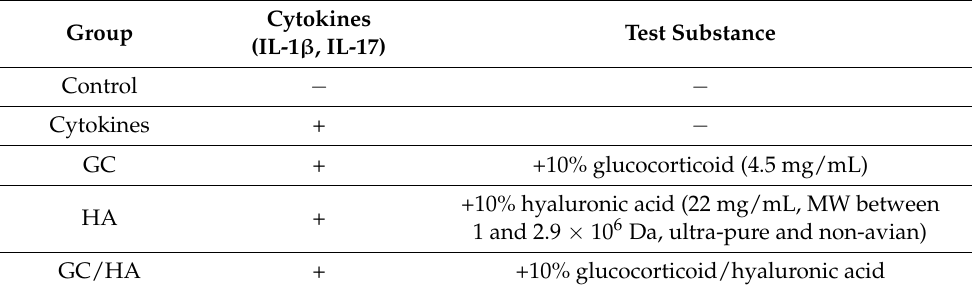
GC/HA + +10% glucocorticoid/hyaluronic